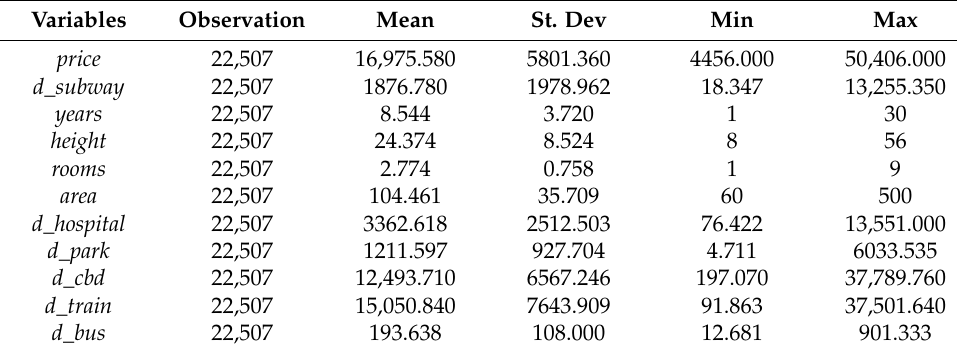
Table 2. Descriptive information for